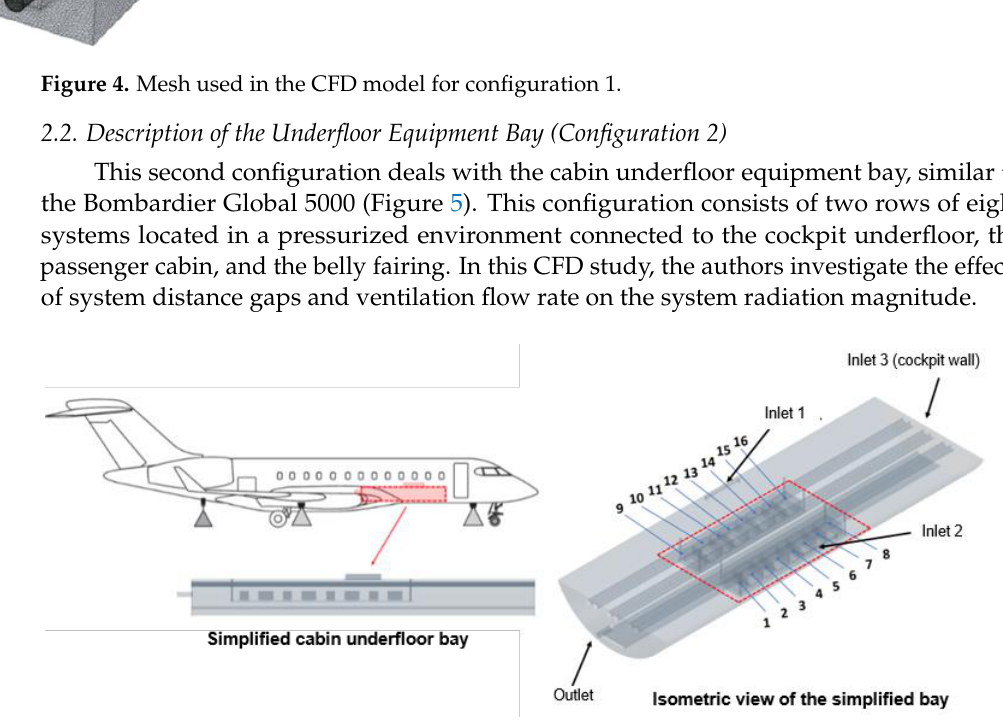
Figure 5. Cabin underfloor equipment bay in a business jet and derived simplified bay model with 16 cubic-shaped systems (Configuration 2).